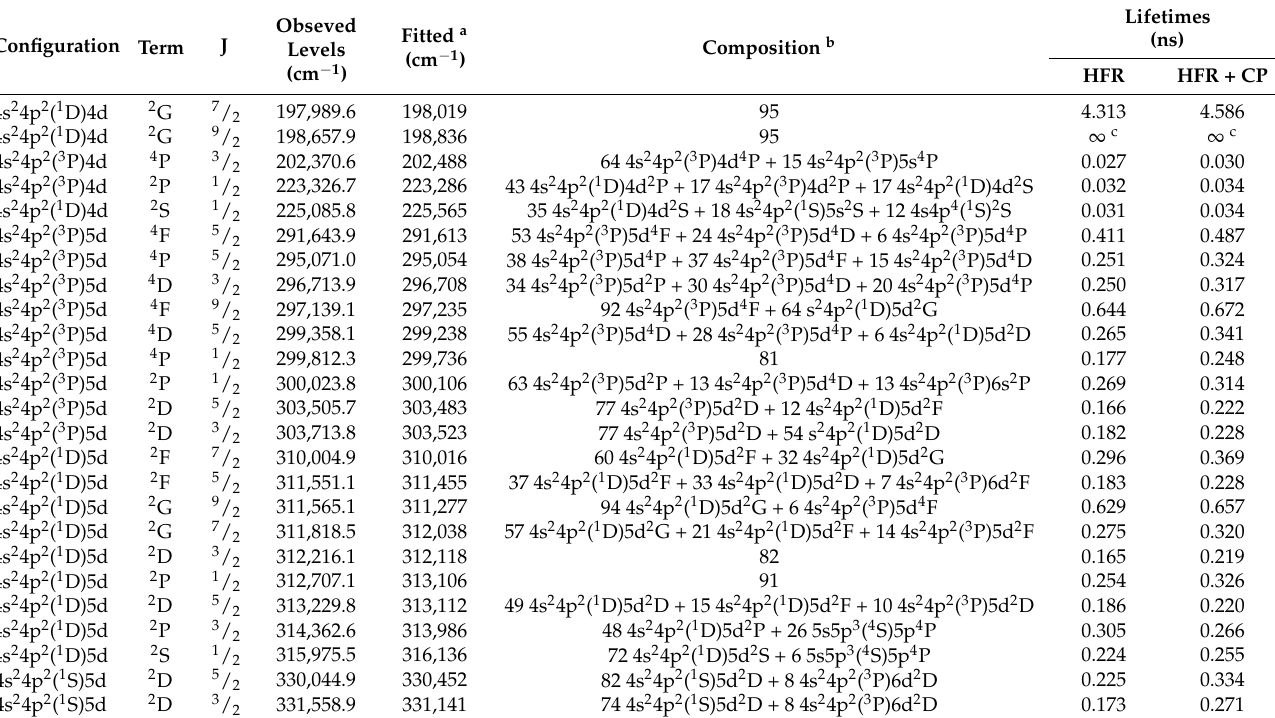
Table 2. New Kr IV energy